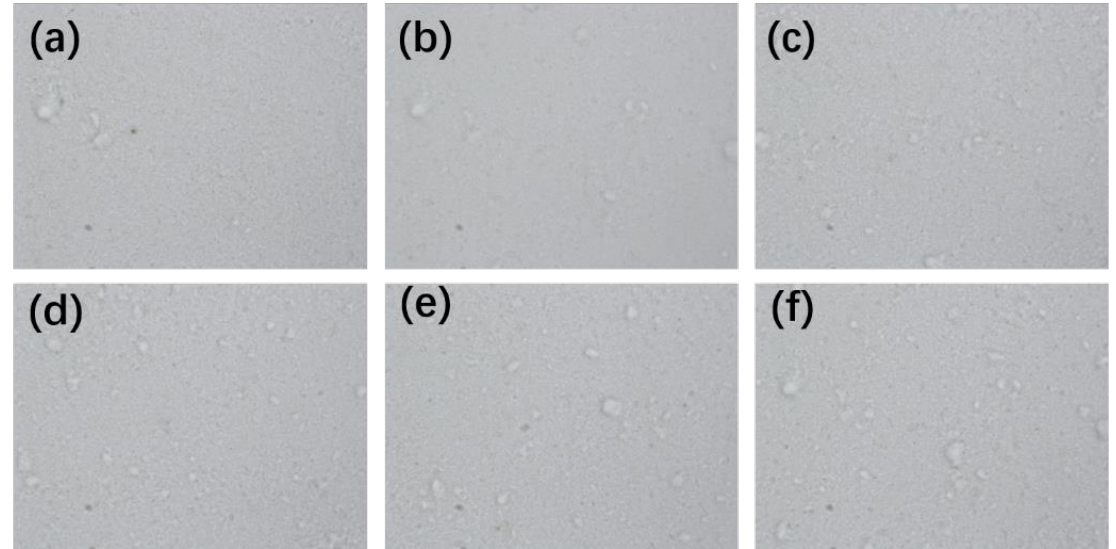
Figure 19. Microscopic image of superhydrophobic coating after six tape peeling. ( a ) First tape peeling, ( b ) second tape peeling, ( c ) the third time of tape peeling, ( d ) the fourth time of tape peeling, ( e ) the fifth time of tape peeling, and ( f ) the sixth time of tape peeling.